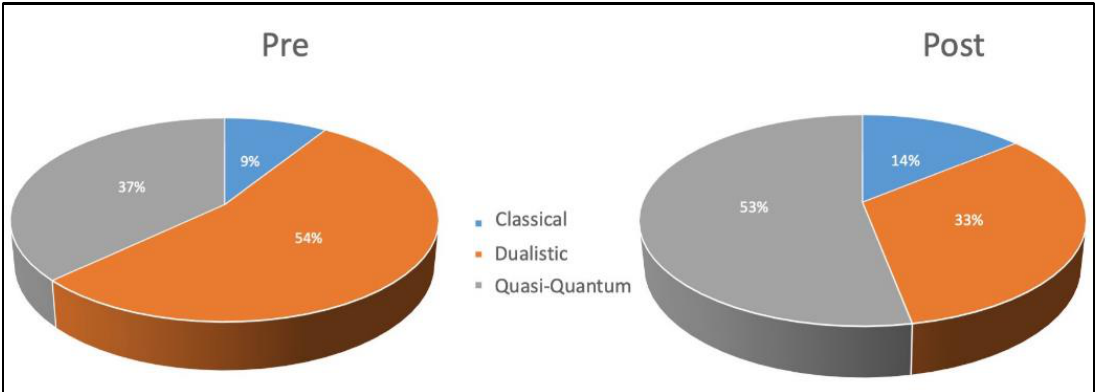
Figure 4. Students‘ understanding of a photon, before (“pre”) and after (“post”) they were engaged with the experiment.